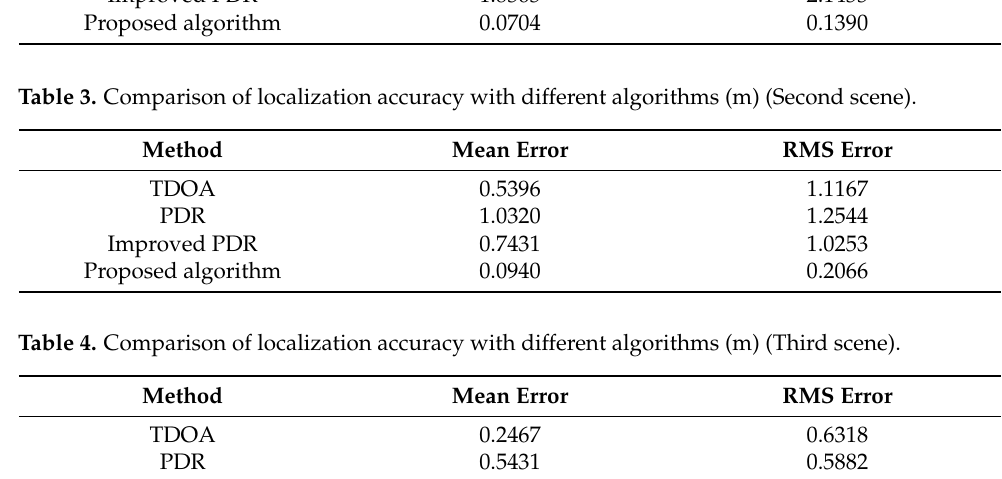
Figure 17. CDF of localization errors with TDOA algorithm, PDR algorithm and the proposed algorithm at different scenes. ( a ) First scene, ( b ) Second scene, ( c ) Third scene.